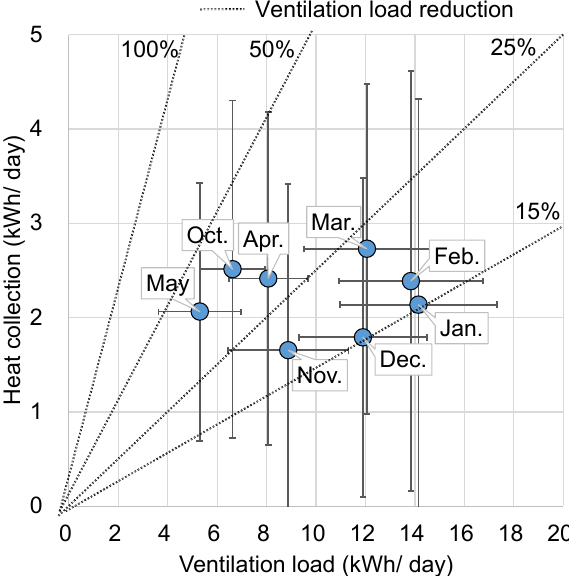
Figure 10. Relationship between heat collection volume and ventilation load.